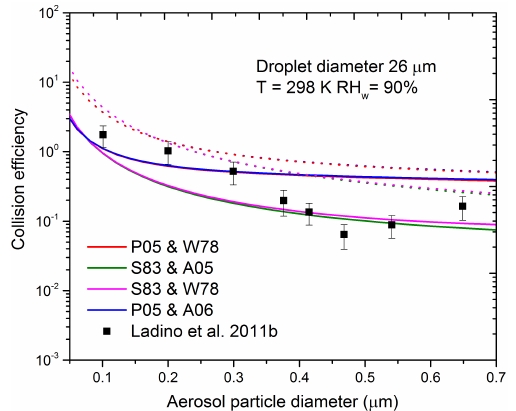
Figure 9. Total collision efficiency for a droplet of 26µm diameter as a function of aerosol particle diameters at a temperature of 298K and 90% relative humidity with respect to water. The black squares indicate the measured collision efficiency by Ladino et al. (2011a). We have assumed charges of 10000e (solid lines) and 50000e (dot- ted